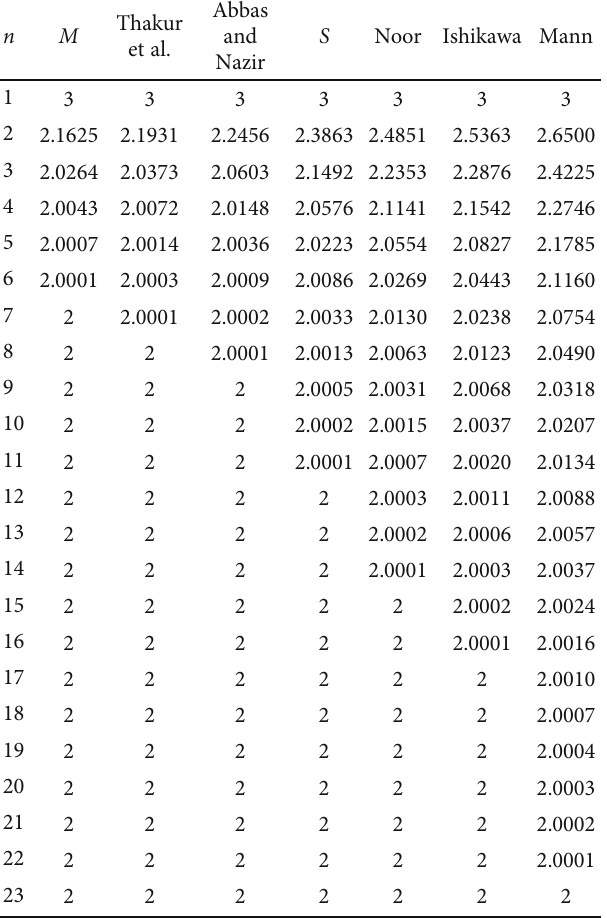
Table 1: Computation table obtained from the M , Thakur et al., Abbas and Nazir, S , Noor, Ishikawa, and Mann iterates for mapping F de fi ned in Example 1.